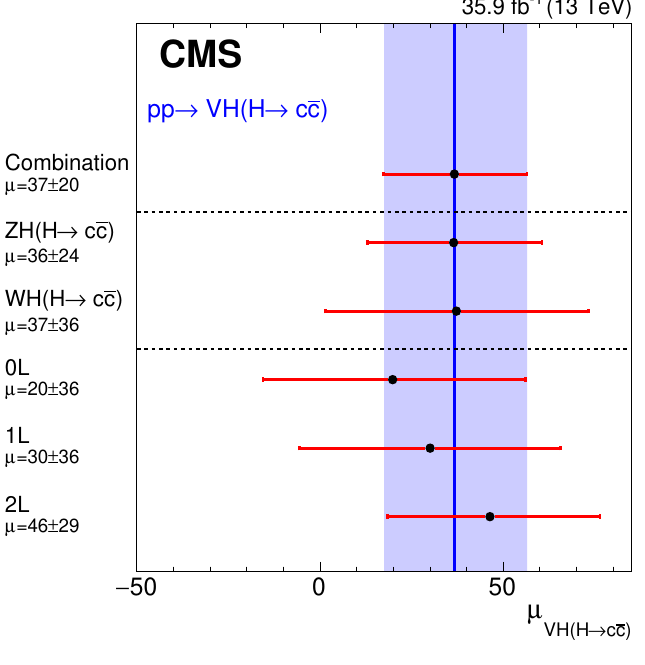
Figure 7 . The (cid:12)tted signal strength (cid:22) for the ZH(H ! cc) and WH(H ! cc) processes, and in each individual channel (0L, 1L, and 2L). The vertical blue line corresponds to the best (cid:12)t value of (cid:22) for the combination of all channels, while the light-purple band corresponds to the (cid:6) 1 (cid:27) uncertainty in the